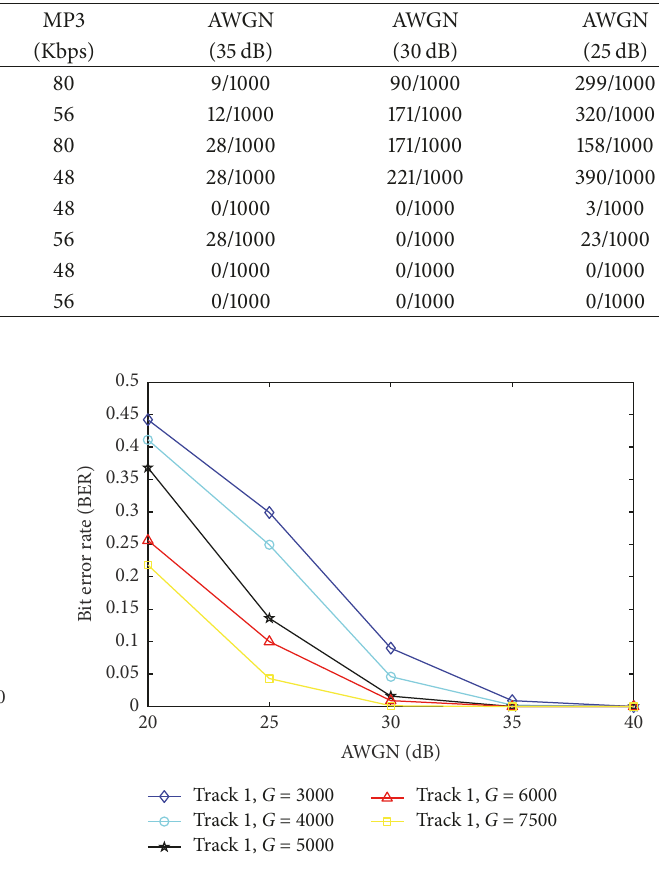
Figure 9: Relationship between MP3 bit rate and threshold 𝐺 . Figure 10: The BER values at different AWGN with different threshold 𝐺